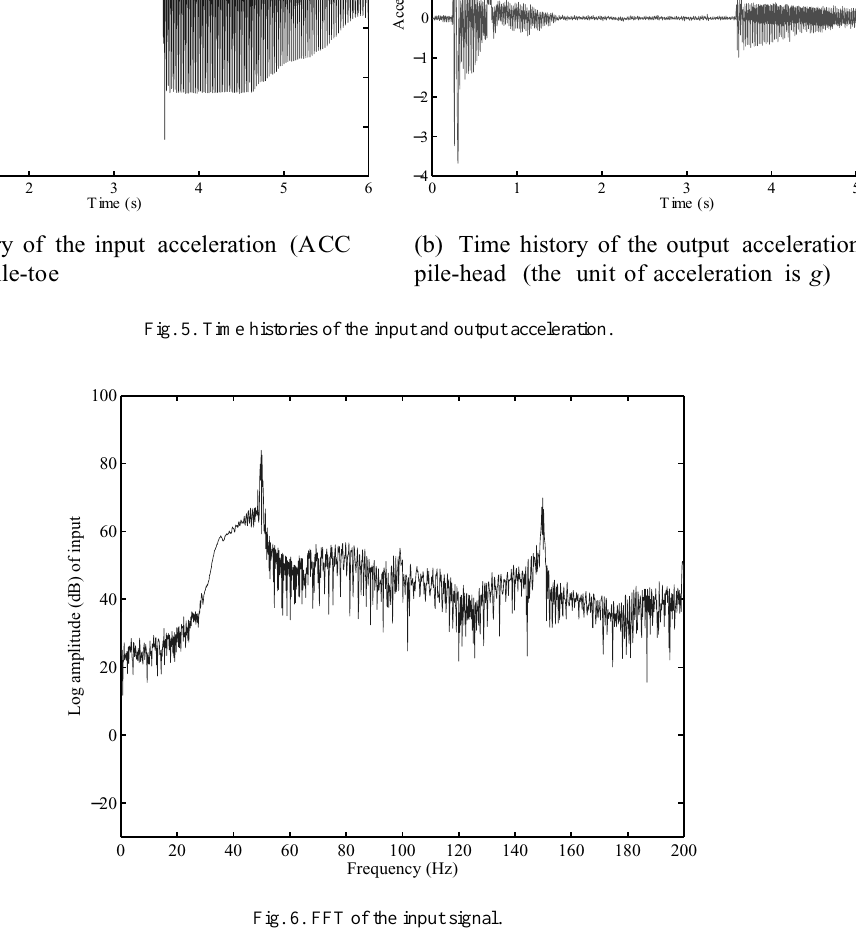
Fig. 6. FFT of the input